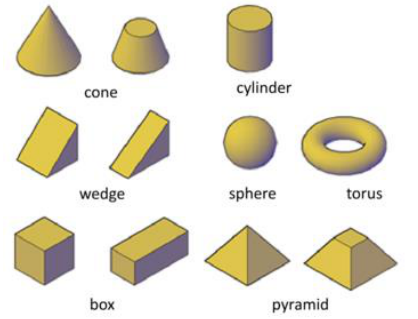
Figure 7. 3D primitive shapes